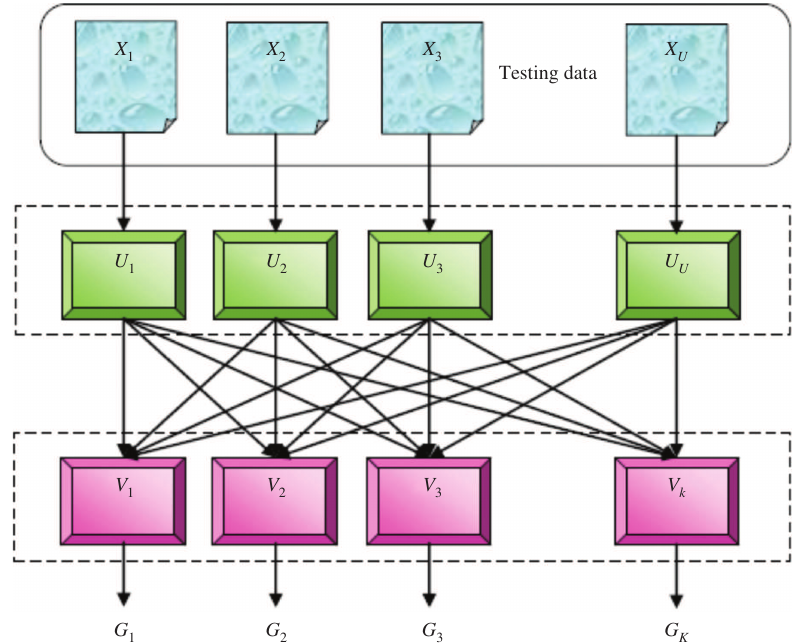
Figure 2: Testing of the FCNB-Based MapReduce